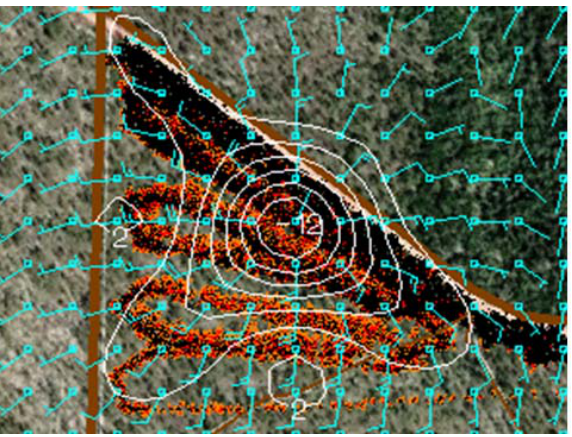
Figure 6. Winds and divergence (1 unit = 0.012 s − 1 ) simulated by Rabbit Rules for a radial-inflow isolated updraft core at 12:22:52. Wind speed convention is the same as that for Figure 4.